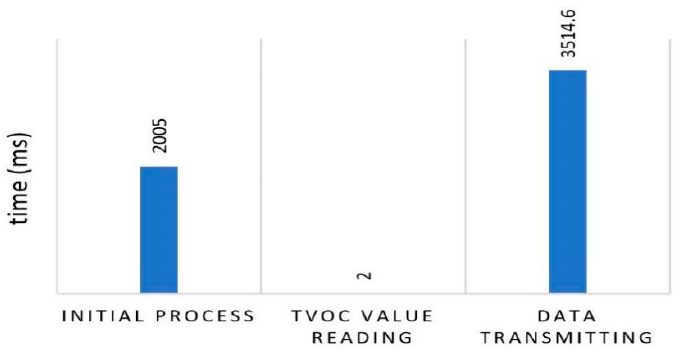
Figure 11. Time measurement.